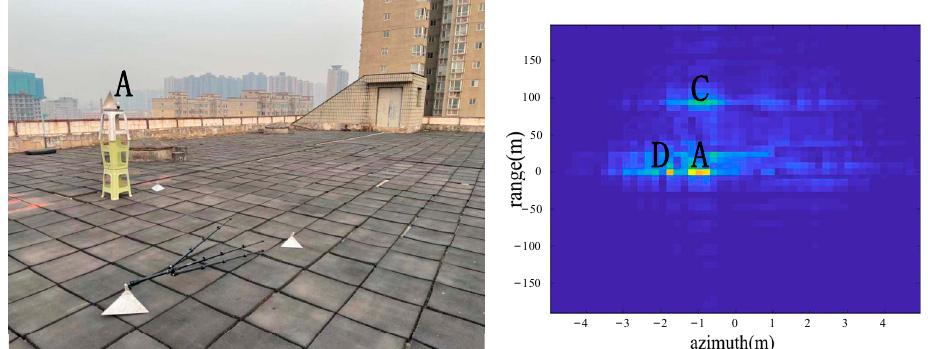
Figure 7. The 2nd group of experimental scenes and imaging results.